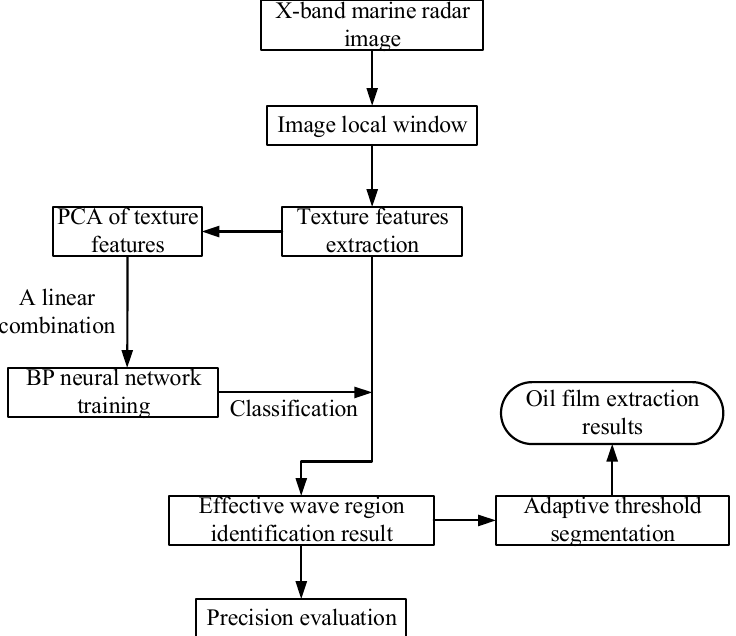
Figure 4. Construction of a BP neural network classifier based on texture features.